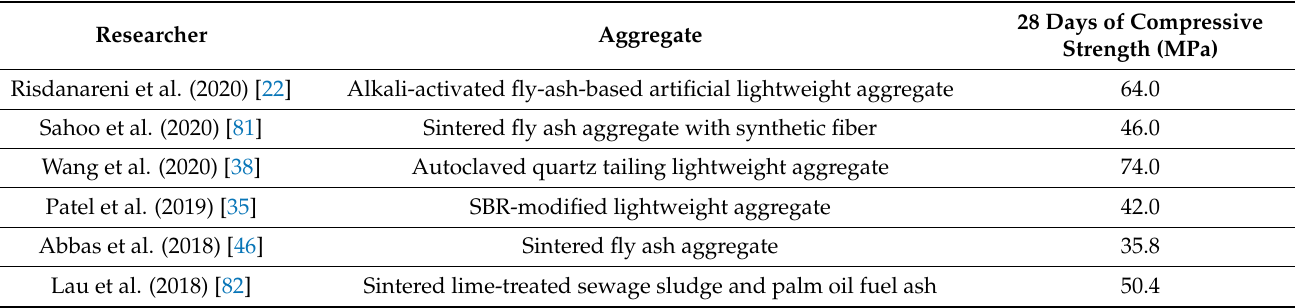
Table 5. Previous studies on compressive strength of lightweight aggregate